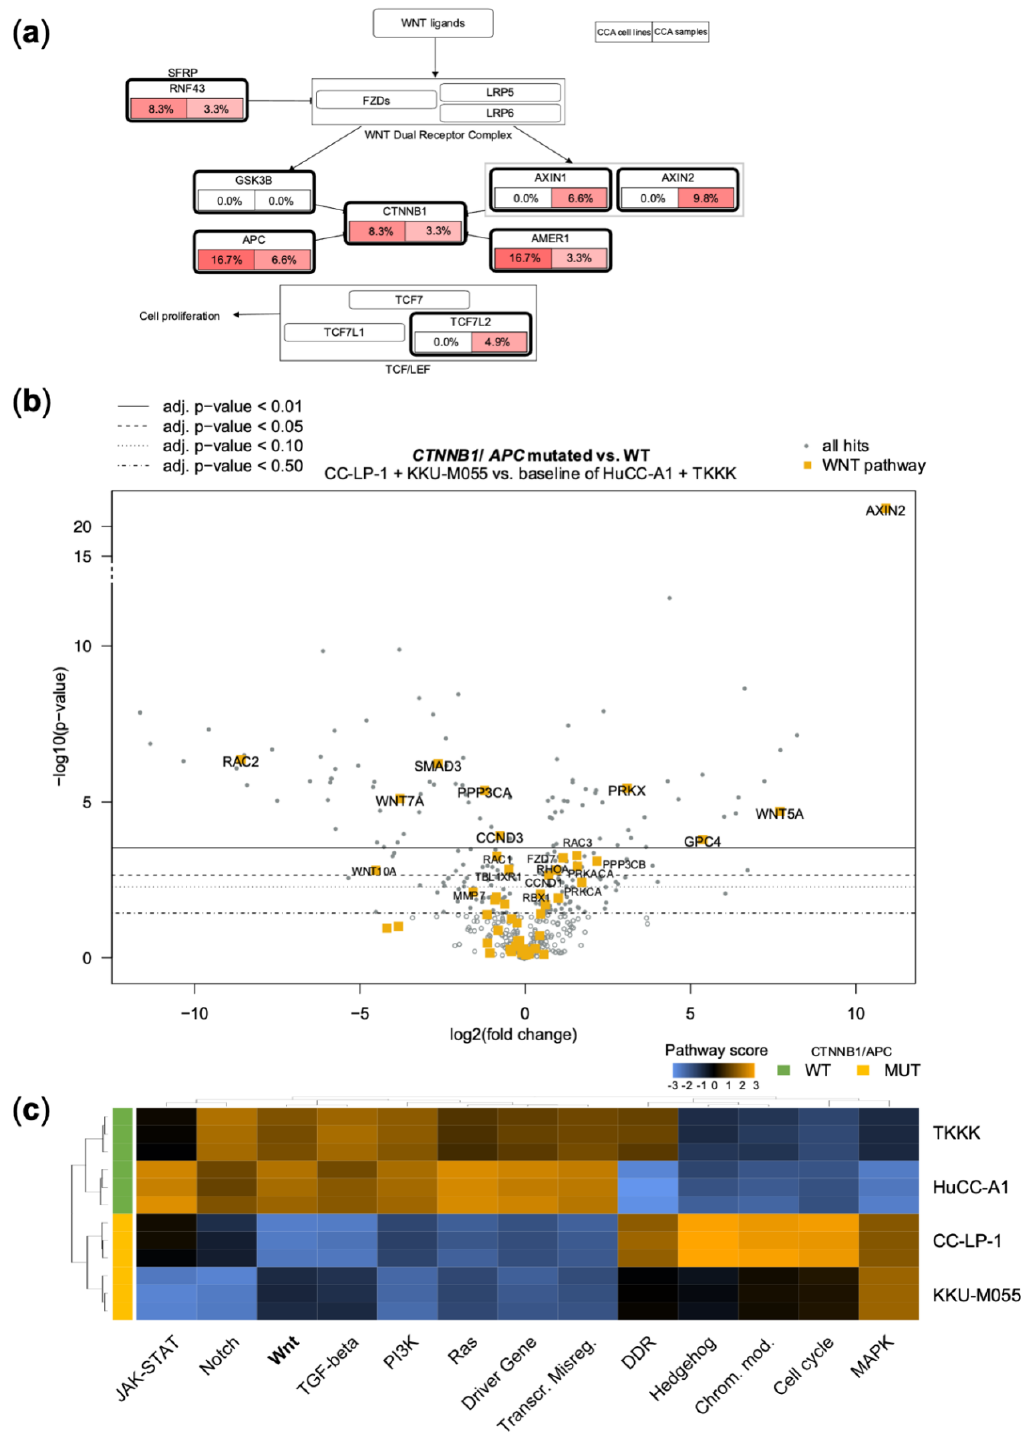
Figure 4. ( a ) Map of WNT pathway-associated genes. The mutational frequencies, including putative driver mutations and variants of unknown significance, are indicated for cell lines ( left ) and CCA tissue samples ( right ). ( b ) Volcano plot of Nanostring ® mRNA measurement using the human Pan Cancer pathway panel ® with highlighted Kegg WNT-pathway hits. Comparison of the CTNNB1 mutated CC-LP-1 and the APC mutated KKU-M055 cell line with the two WNT pathway wild-type cell lines HuCC-A1 and TKKK. ( c ) Heatmap showing pathway scores across indicated cholangiocarcinoma cell lines to illustrate clustering of pathways within samples. Orange indicates high pathway scores; blue indicates low pathway scores (with undetermined functional dimension).